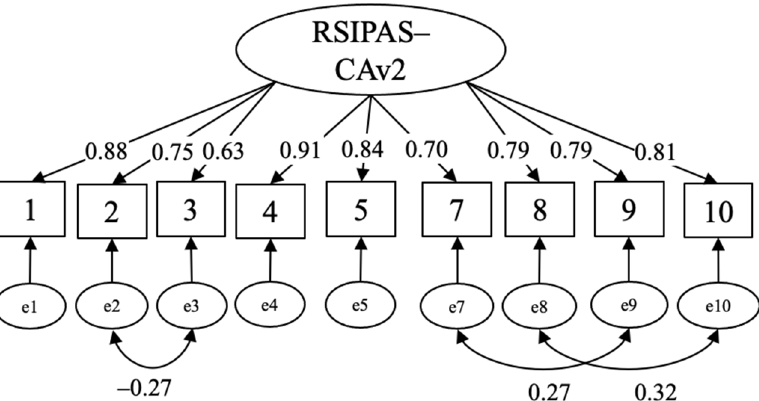
Figure 2. Final Model with Standardized Loadings and Correlated Error Terms. RSIPAS-CAv2 =